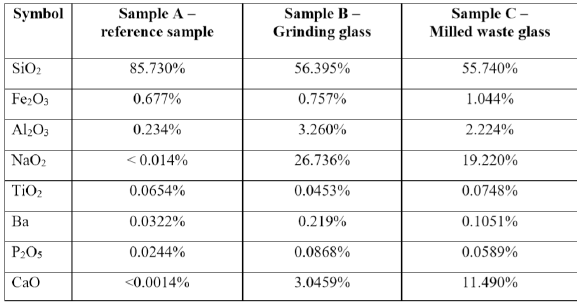
Table 2. Results of chemical